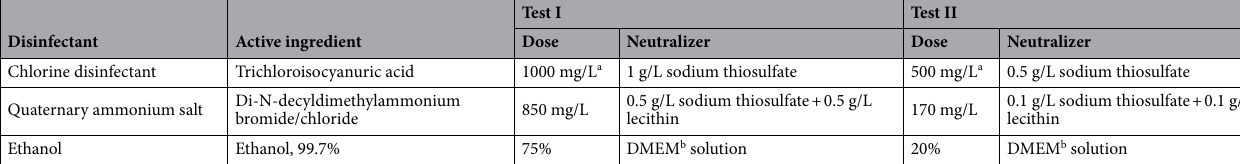
Table 1. Chemical information and neutralizer experiments. a Concentrations of available chlorine. b Dulbecco’s Modified Eagle